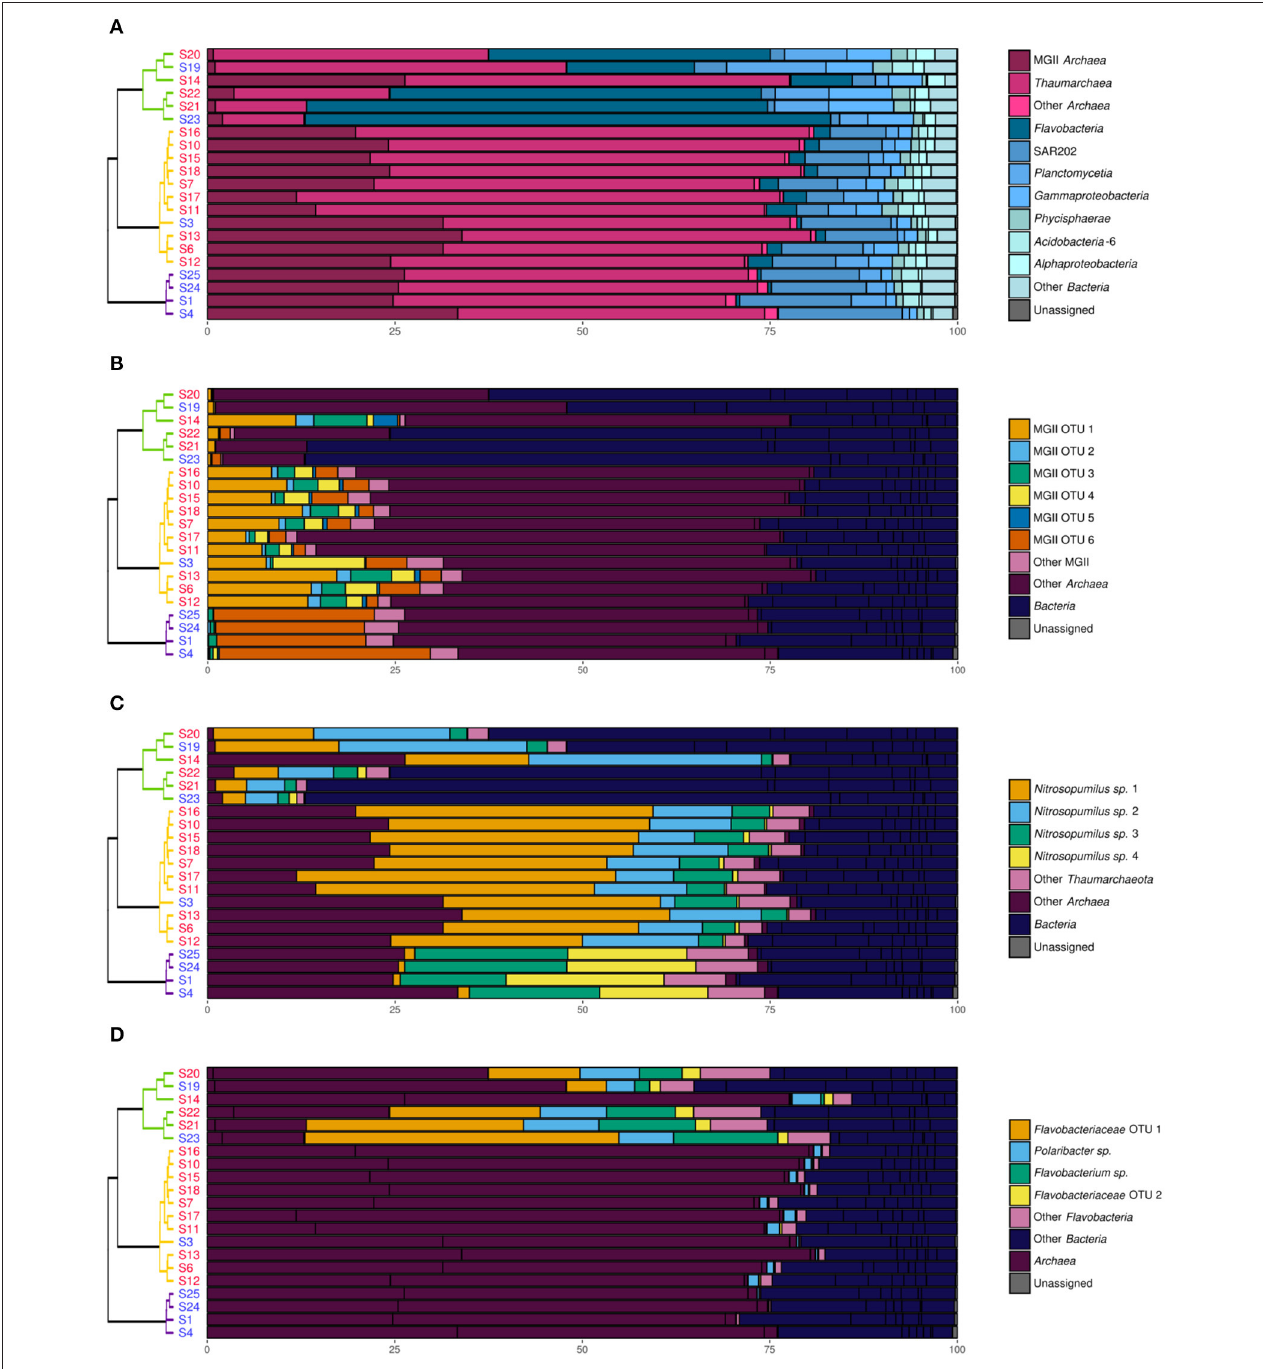
FIGURE 5 | Relative abundance (in %) of various prokaryotic taxonomic groups in the samples. The dendrogram and the sample names are as shown in Figure 2 . (A) Taxonomical distribution at the class/family level. (B) Distribution of the 97% level OTUs within the MGII family. (C) Distribution of the 97% level OTUs within the Thaumarchaeota class. (D) Distribution of the 97% level OTUs within the Flavobacteria class.